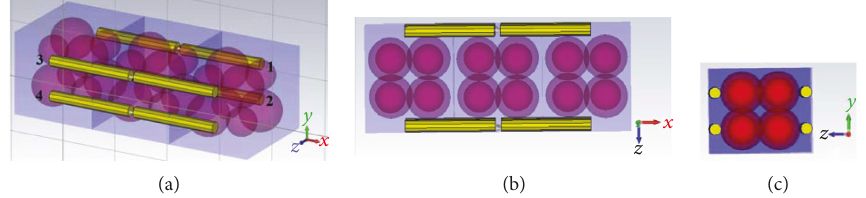
Figure 8: Dipole ’ s length 30mm and radius 1mm. The dipoles ’ positions along y -direction, measured from the “ bottom ” side, are 10.56mm for dipoles 1 and 3 and 4.22mm for dipoles 2 and 4. Total scheme size: 44.34mm × 14.78mm × 17.78mm. (a) 3D view, (b) top view, and (c) side